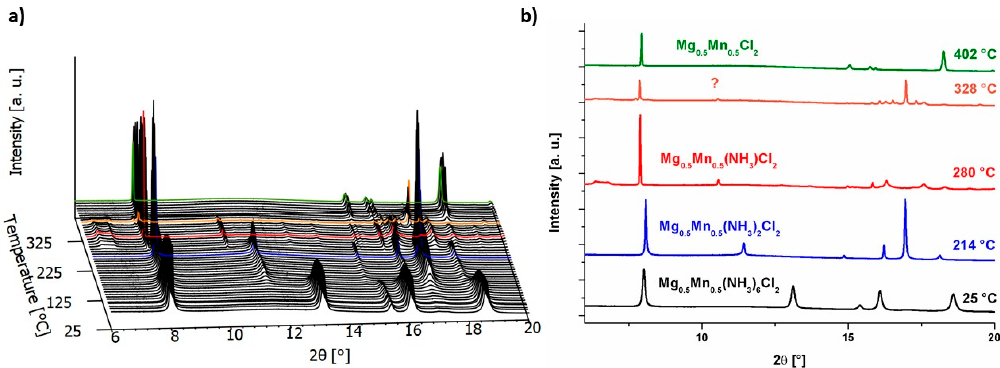
Figure 5. ( a ) In situ SR-PXD of Mg 0.5 Mn 0.5 (NH 3 ) 6 Cl 2 measured from RT to 402 °C with a heating rate